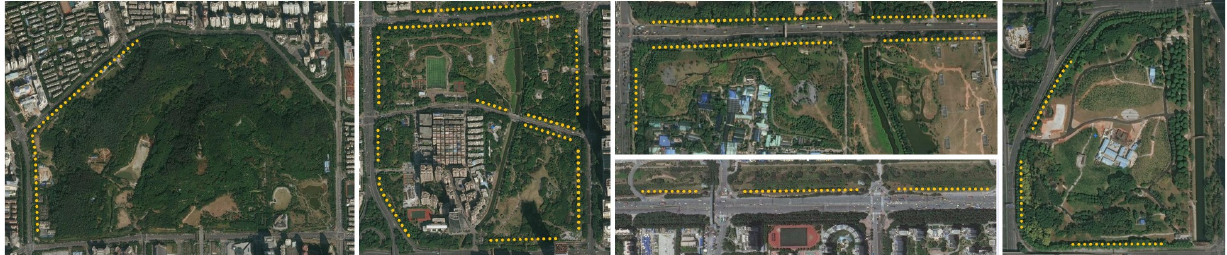
Figure 2. Study area.